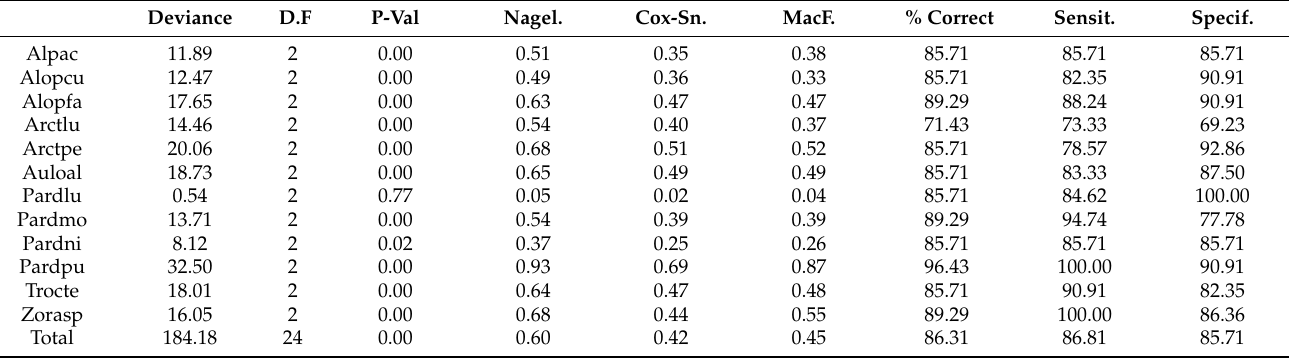
Table 7. Measures of fit for the spider data.